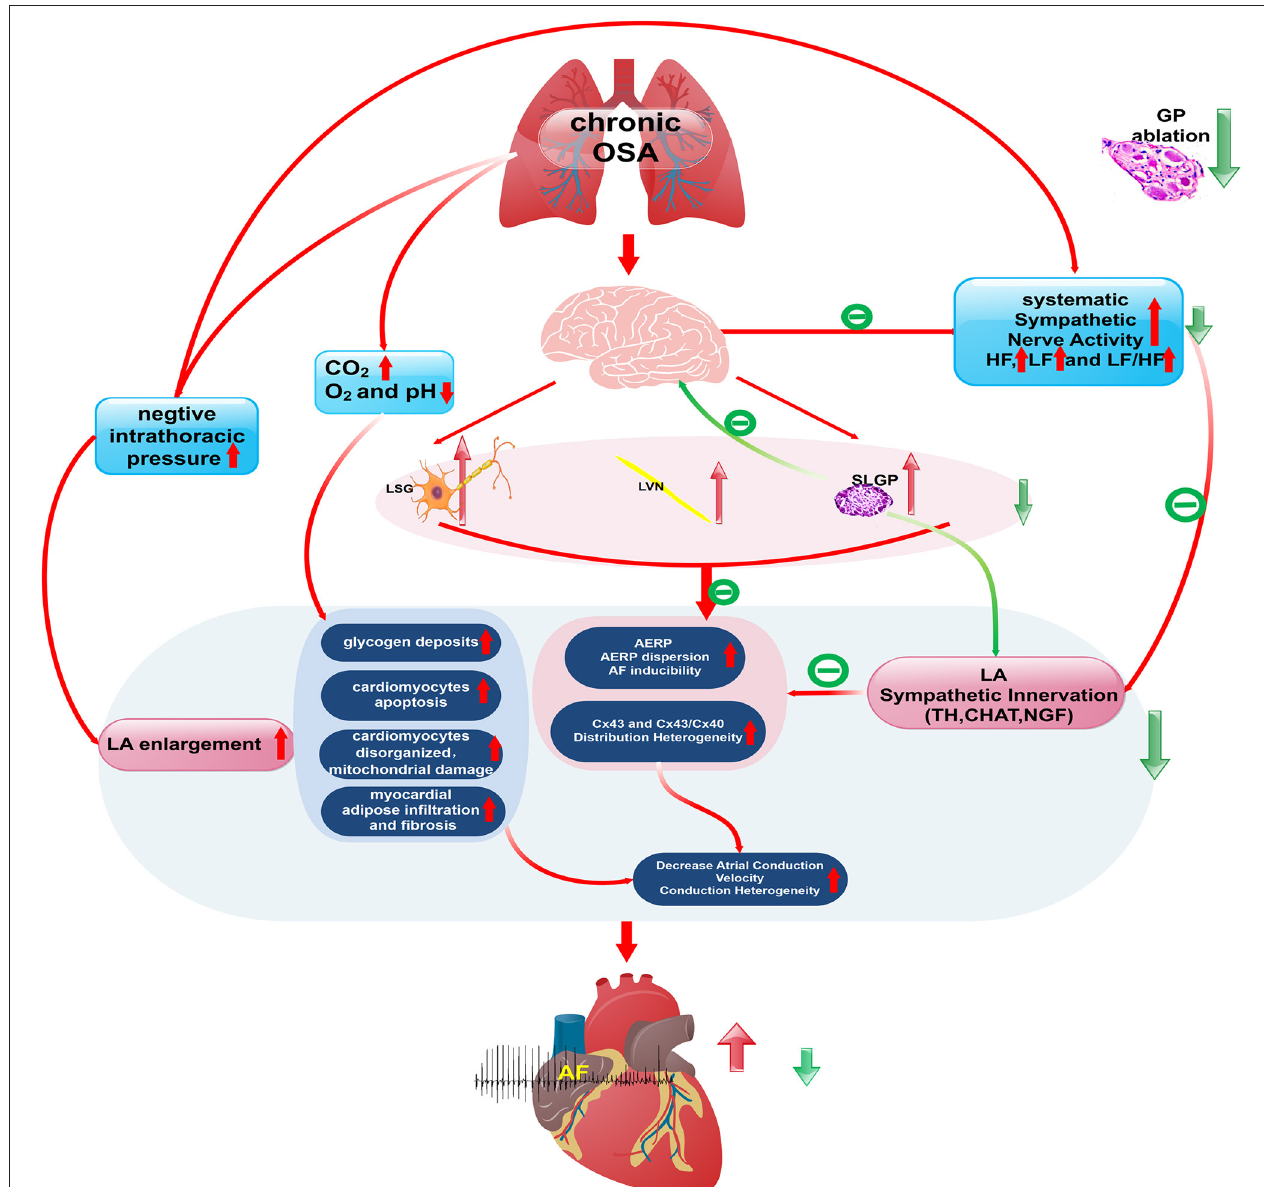
FIGURE 13 | The schematic diagram illustrates the underlying mechanism by which SLGP ablation attenuates chronic OSA-associated AF.